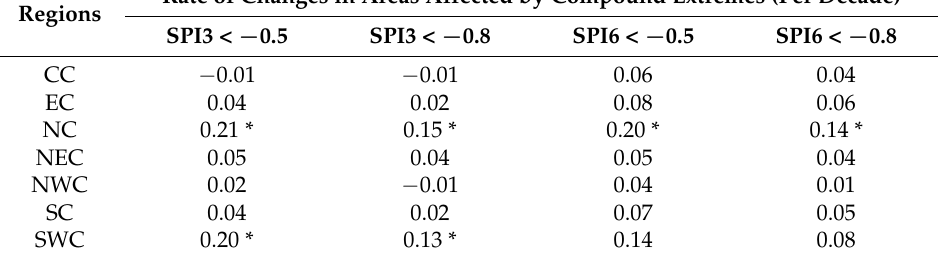
Table 1. Trend tests of the spatial extent of compound droughts and hot extremes for different regions in China (at the 0.05 significance level) during 1953–2012. Rate of Changes in Areas Affected by Compound Extremes (Per Decade) Regions SPI3 < −